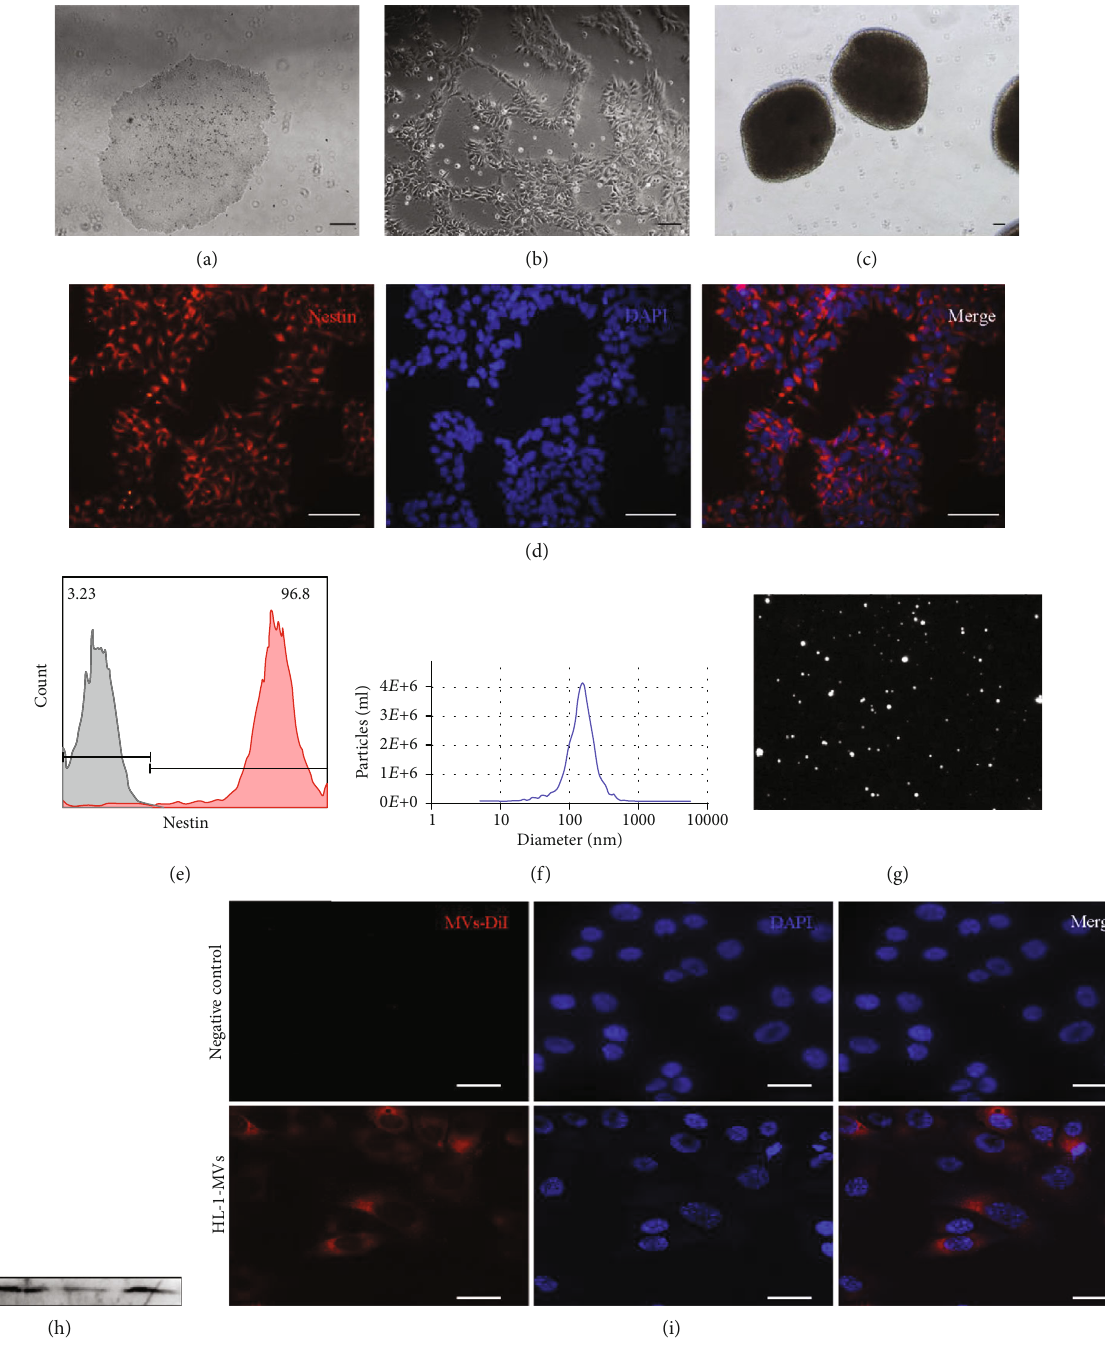
Figure 2: Characterization of hESC-NSC and hESC-NSC-derived MVs. The phase morphology of hESCs and NSCs growing on Matrigel- coated dish (a, b). Typical morphological neurospheres of NSCs (c). hESC-NSC were immuno fl uorescence staining for nestin (d). Flow cytometry analyzed purity of nestin, gray line: isotype control; red line: hESC-NSCs (e). Nanoparticle tra ffi cking analyzed the diameters of MVs. The particles were 1 : 17 E + 10 particles/ml, and the diameters of the particles were within the range of 50 – 1000 nm, with the average of 152.5nm (f). A representative screenshot of the NTA video, the bright white dot indicates one moving particle (g). Western blotting characterized microvesicle marker CD63, three replicate samples (h). Representative confocal microscopy of HL-1 cells that was exposed to Dil-labelled MVs (i). ((a – d): scale bars 100 μ m; (h): scale bars 15 μ